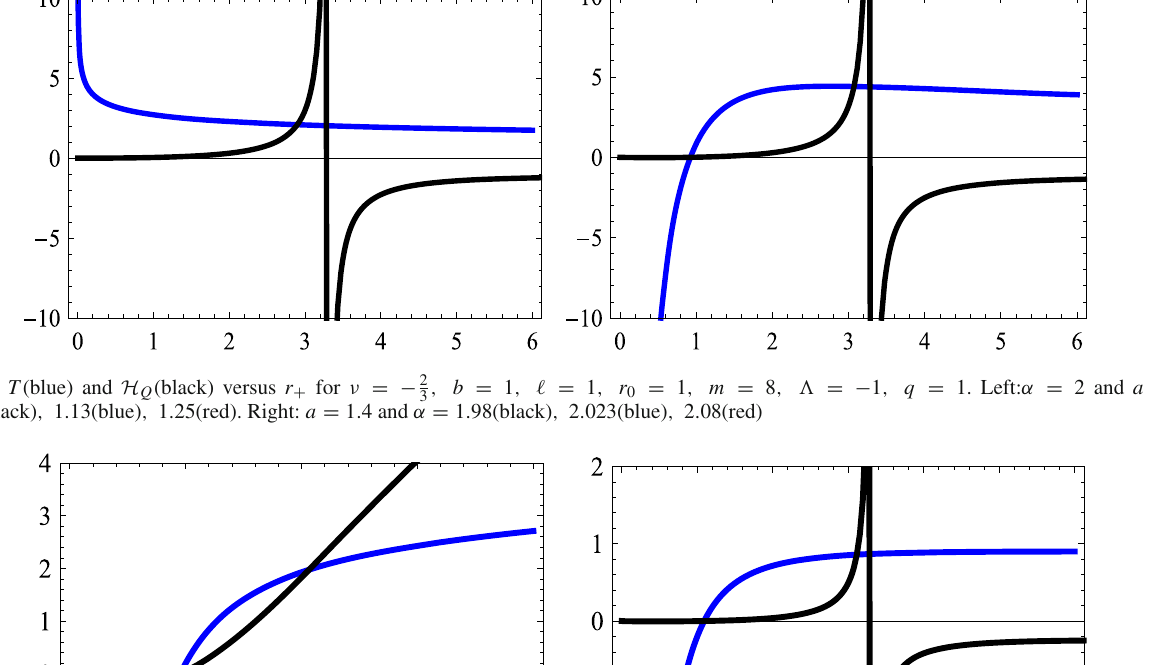
, b = 1 , (cid:20) = 1 , r = 1 , m = 8 , (cid:18) = − 1 , q = 1. Left: α = 2 and a = 0 3